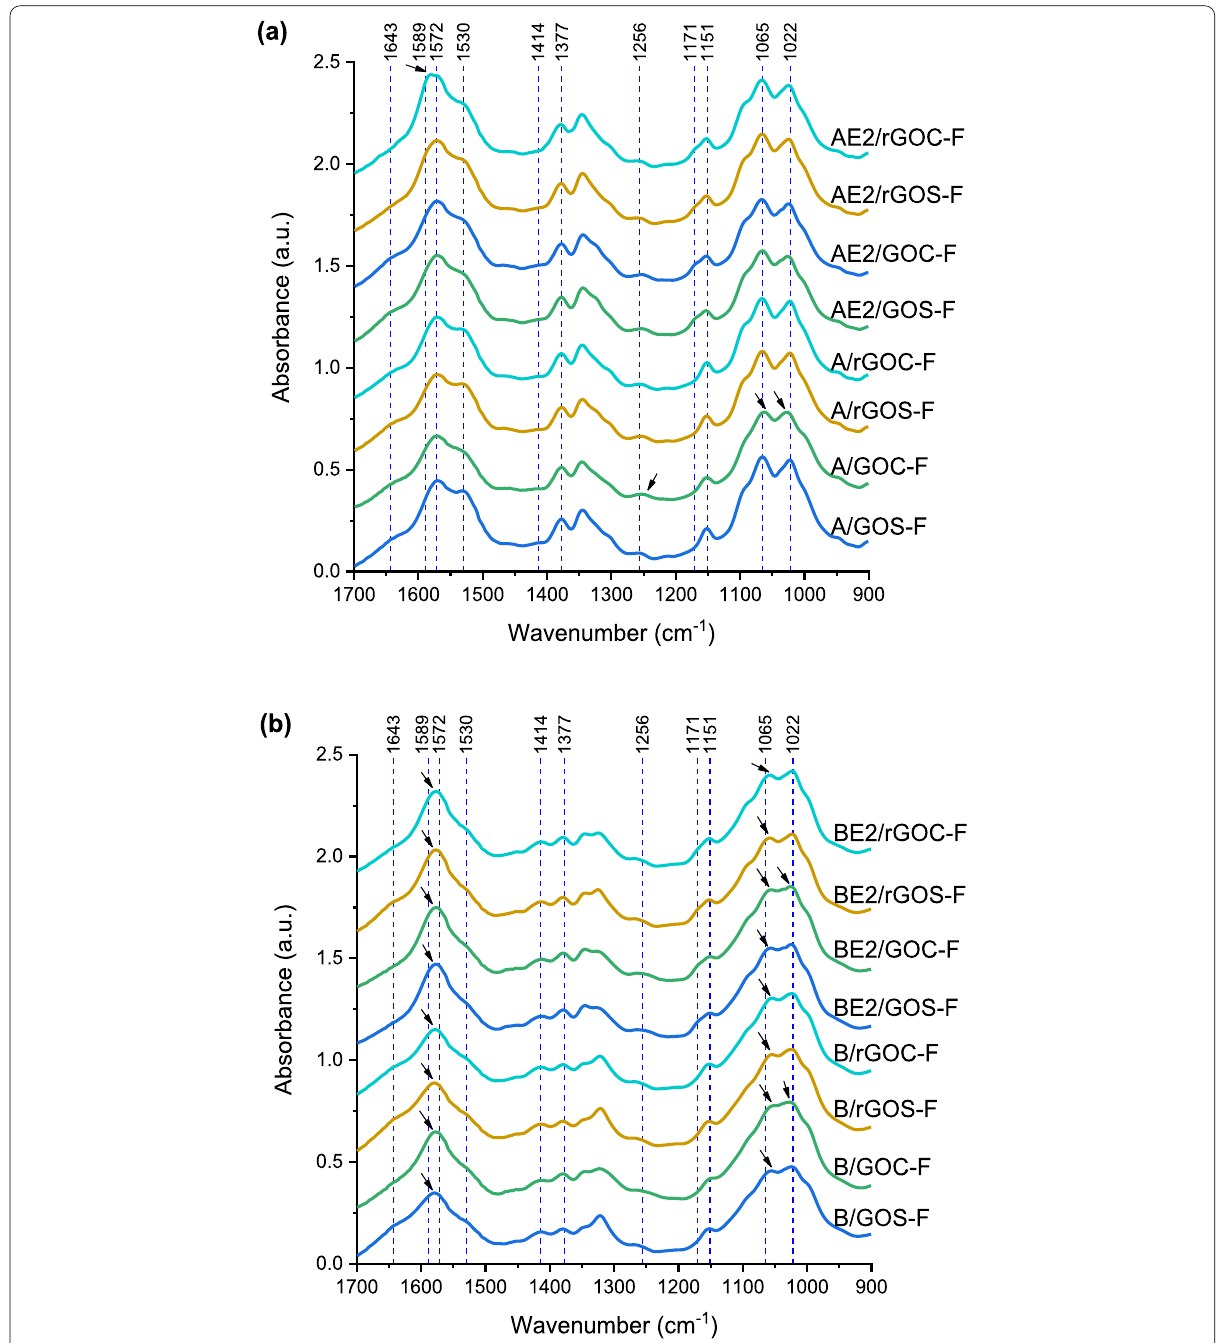
Fig. 2 Fourier-transform infrared (FTIR) spectra for the different a chitosan and b chitosan/carboxymethyl cellulose (CMC)-based nanocomposite films. The reference lines denotes characteristic bands 1171 cm − 1 for [C 2 mim][OAc] [39], 1589, 1414 and 1022 cm − 1 for CMC, 1643, 1572, 1530, 1377, 1256, 1151, 1065, and 1022 cm − 1 for chitosan [21]. The arrows signify peak shifting or peak intensity